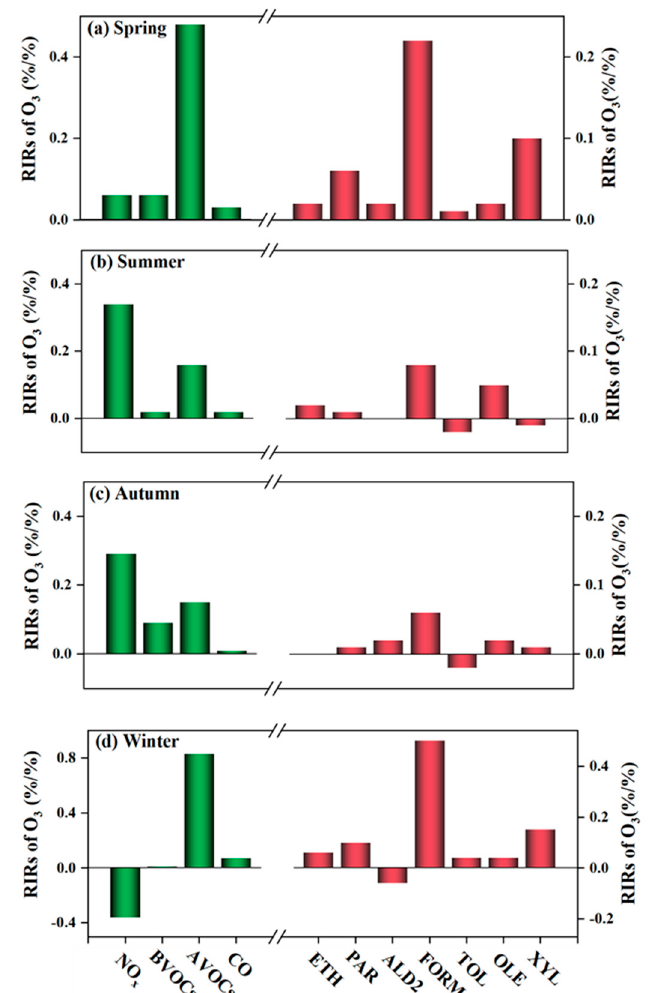
Figure 5. The observation-based models (OBM) calculated relative incremental reactivity (RIR) for O 3 precursors (green) and specific species (red) in ( a ) spring, ( b ) summer, ( c ) autumn, and ( d ) winter during the daytime (07:00–19:00). BVOCs and AVOCs stand for biological VOCs and anthropogenic VOCs, respectively. ETH, PAR, ALD2, FORM, TOL, OLE, and XYL stand for ethylene, alkanes, aldehydes other than formaldehyde, formaldehyde, toluene, alkenes other than ethylene, and xylene, respectively. If the RIR value is positive, the reduction of precursors contributes to O 3 reduction, while a negative value means that precursor reduction may lead to an increase in O 3 concentration.